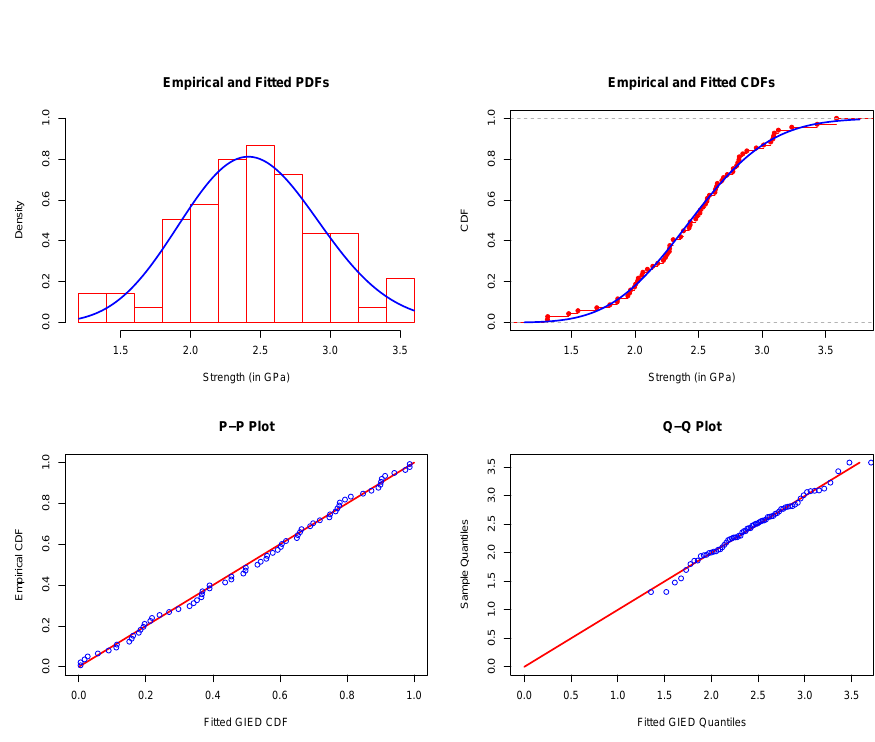
Figure 2 – Diagnostic plots for the fitted GIED for data set 2 ( Y : gauge length 20